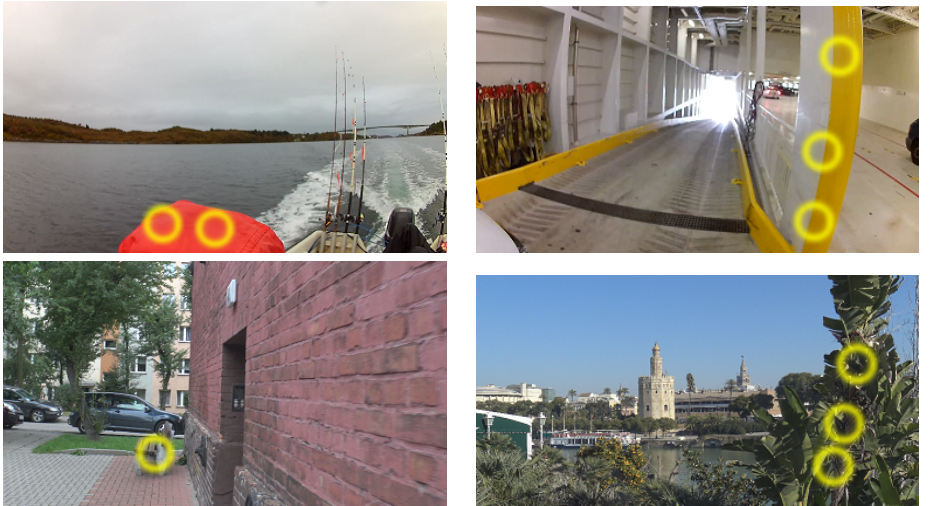
Figure 7. Sample frames from selected video files recorded with different devices in different weather conditions. Yellow circles indicate detected obstacles. The users were recording in various conditions: from moving vehicles with low visibility (User 1), in corridors and buildings with various levels of lighting (User 2), and in an open city space with good visibility and lightness (User